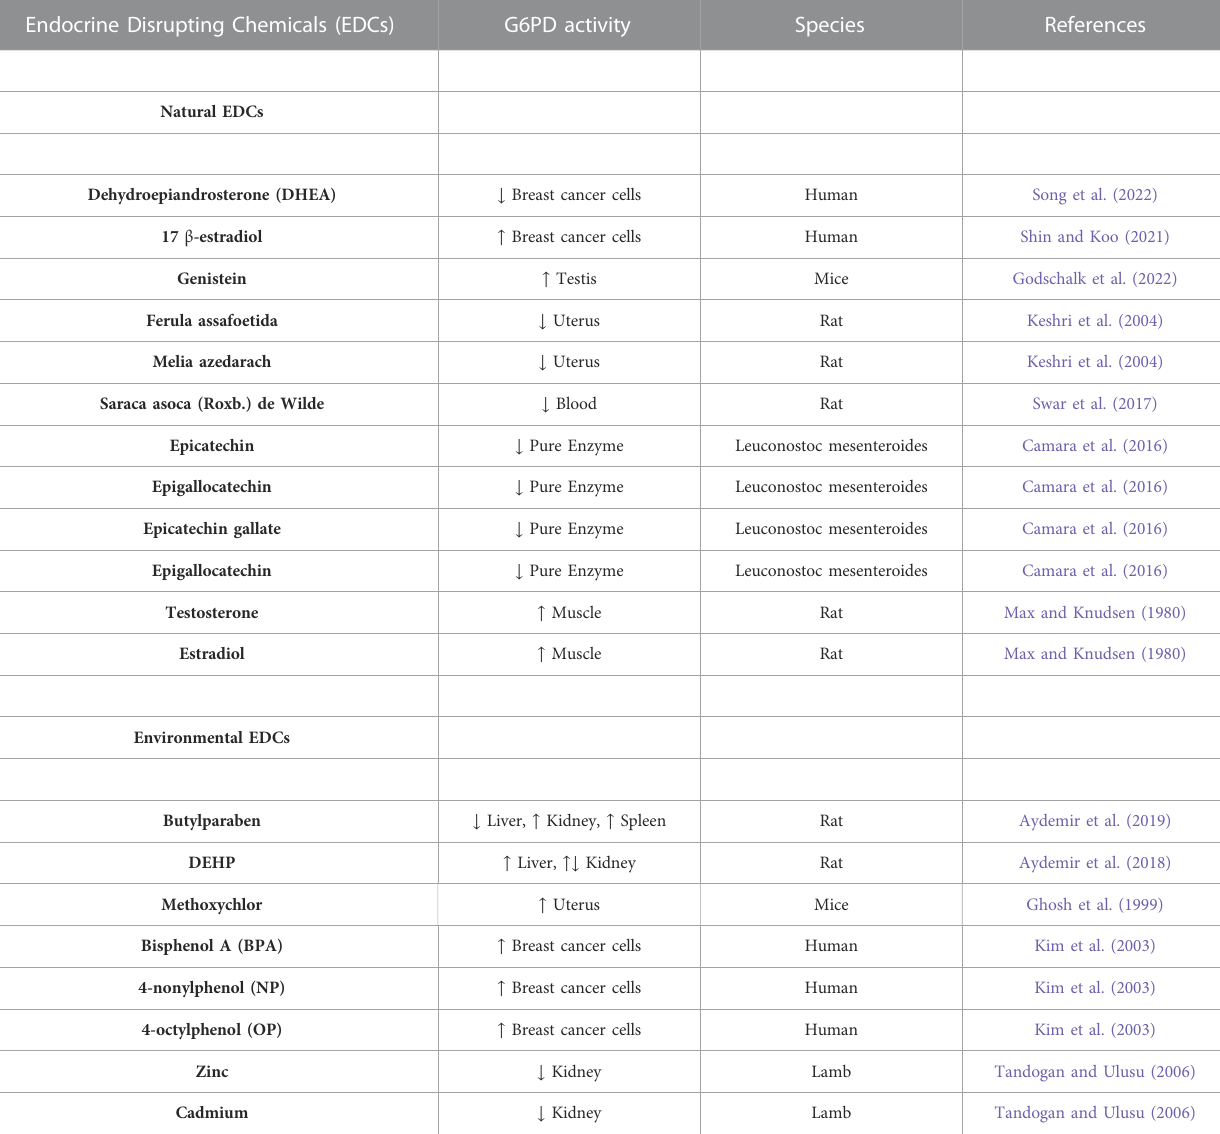
TABLE 1 Impact of the natural and environmental endocrine disrupting chemicals (EDCS) on the G6PD enzyme activity in different species. Endocrine Disrupting Chemicals